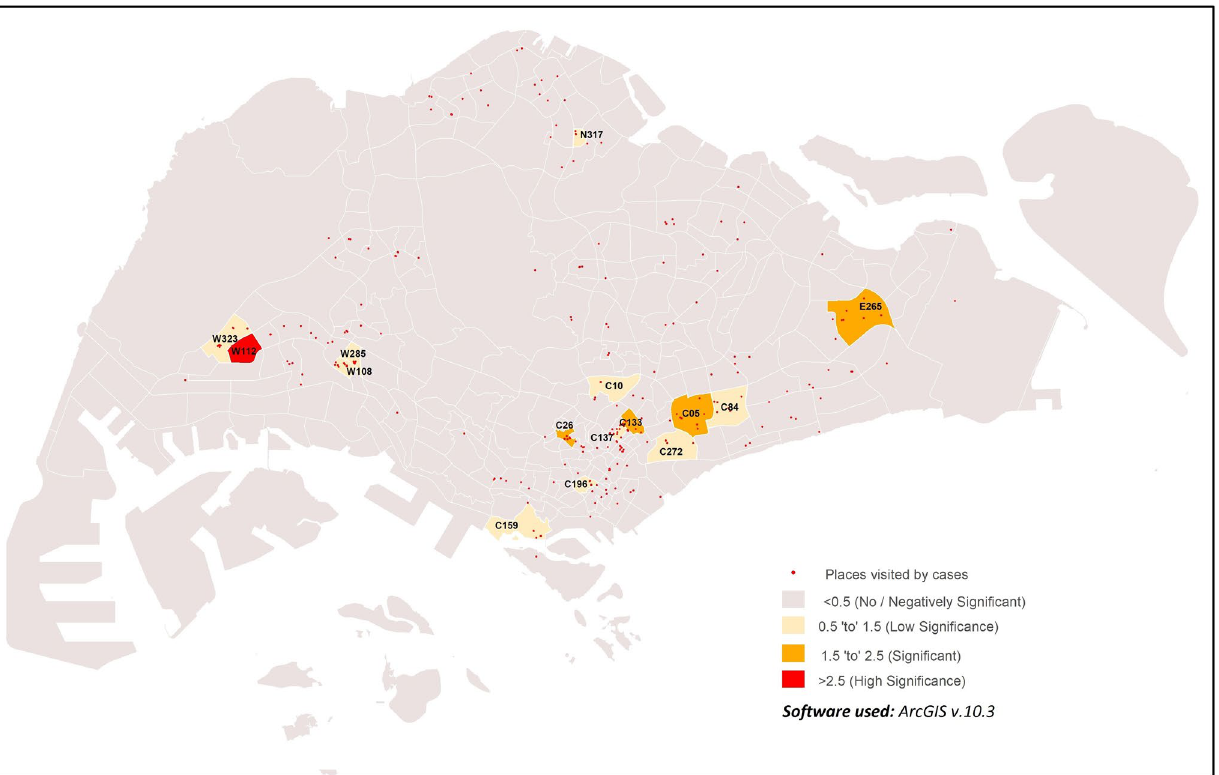
Figure 6. GWR levels of urbanisation and places visited by COVID-19 cases from 19th May 2020 to 31st July 2020.